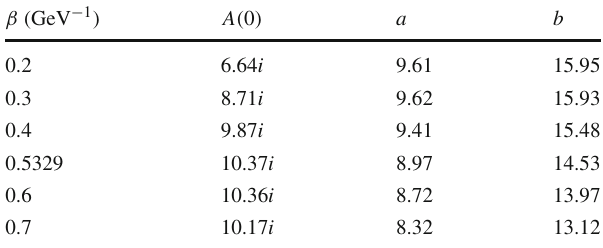
Table 1 The amplitude of X ( 5568 ) → B s π + with three parameters ( (cid:9) = 0 . 88